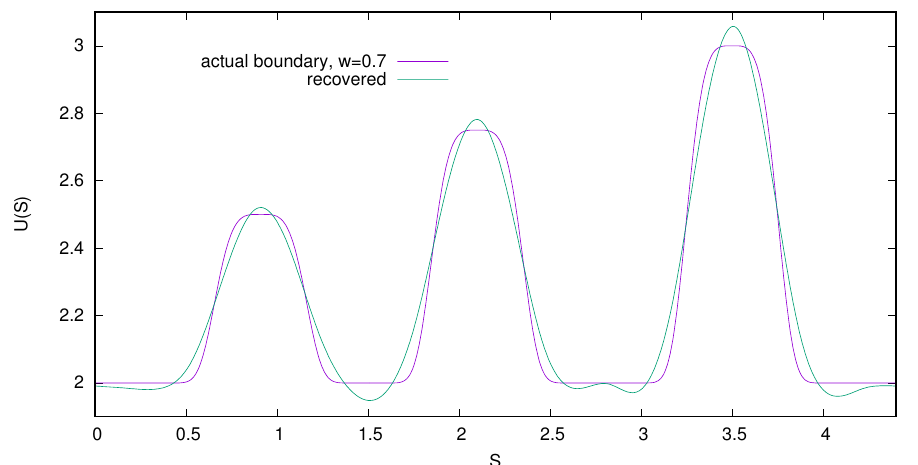
Figure 7. Recovered unknown interior boundary for example 3 with (0.04%) noise.